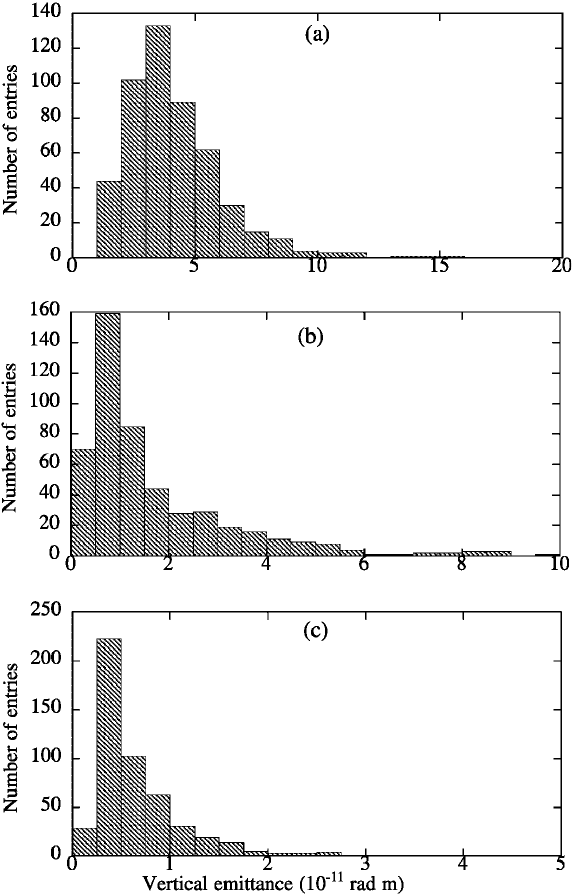
FIG. 3. Distribution of (cid:26) ( 10 (cid:6) 11 rad m ) (a) after COD cor- y rection, (b) after COD-dispersion correction, and (c) after coupling correction. Note the different horizontal